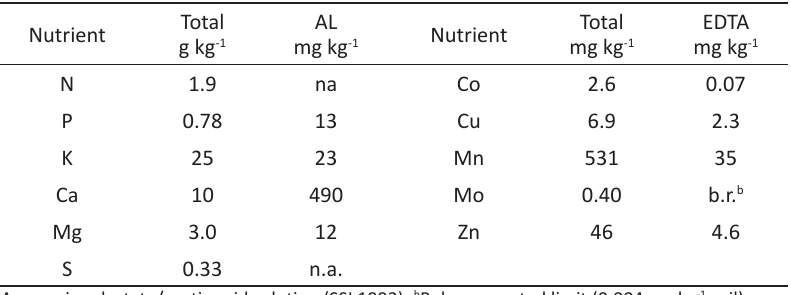
Table 1. Original total and extractable (AL a or EDTA) concentrations of nutrients in the soil used for the pot experiment